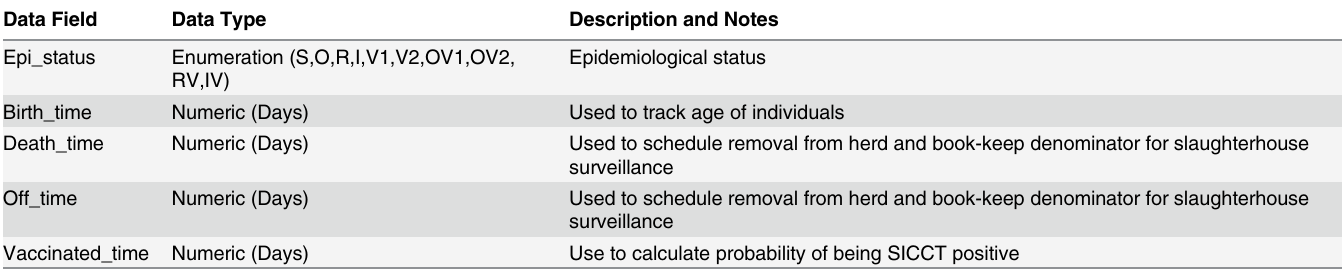
Table 6. Individual animal variables.